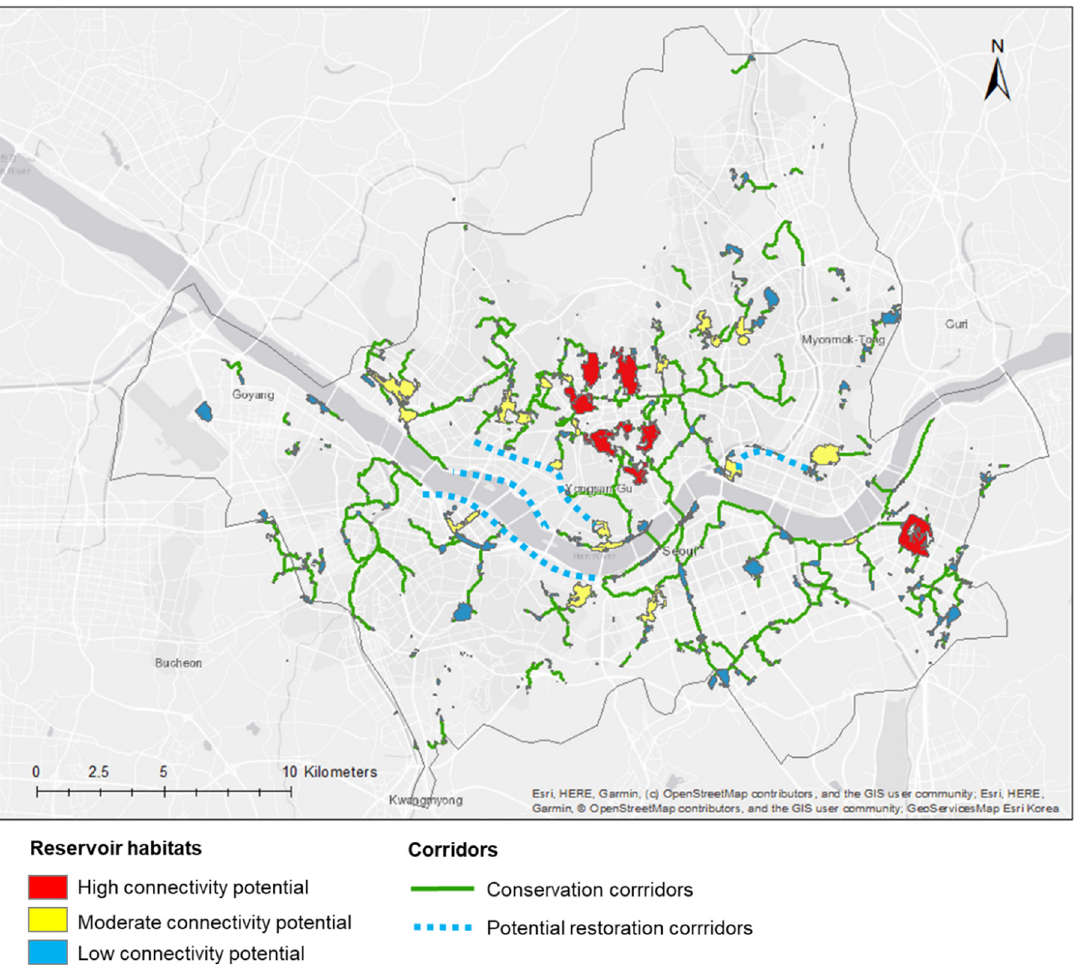
Figure 6. Synthesis map of corridors to maintain and restore to improve connectivity for wild pollinators in Seoul.